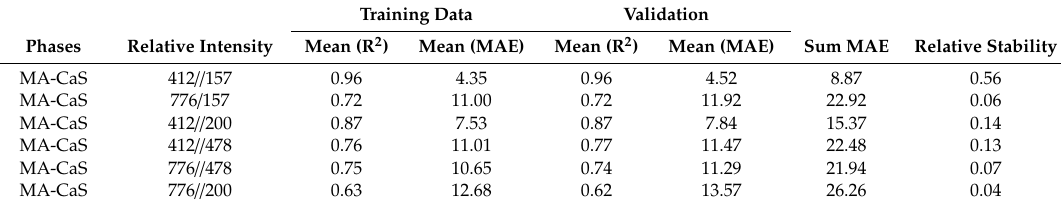
Table 5. Evaluation of the coe ffi cient of determination (R 2 ) and mean absolute error (MAE) for the prediction and validation between the phase content and relative intensity of the Raman peaks and phase content for